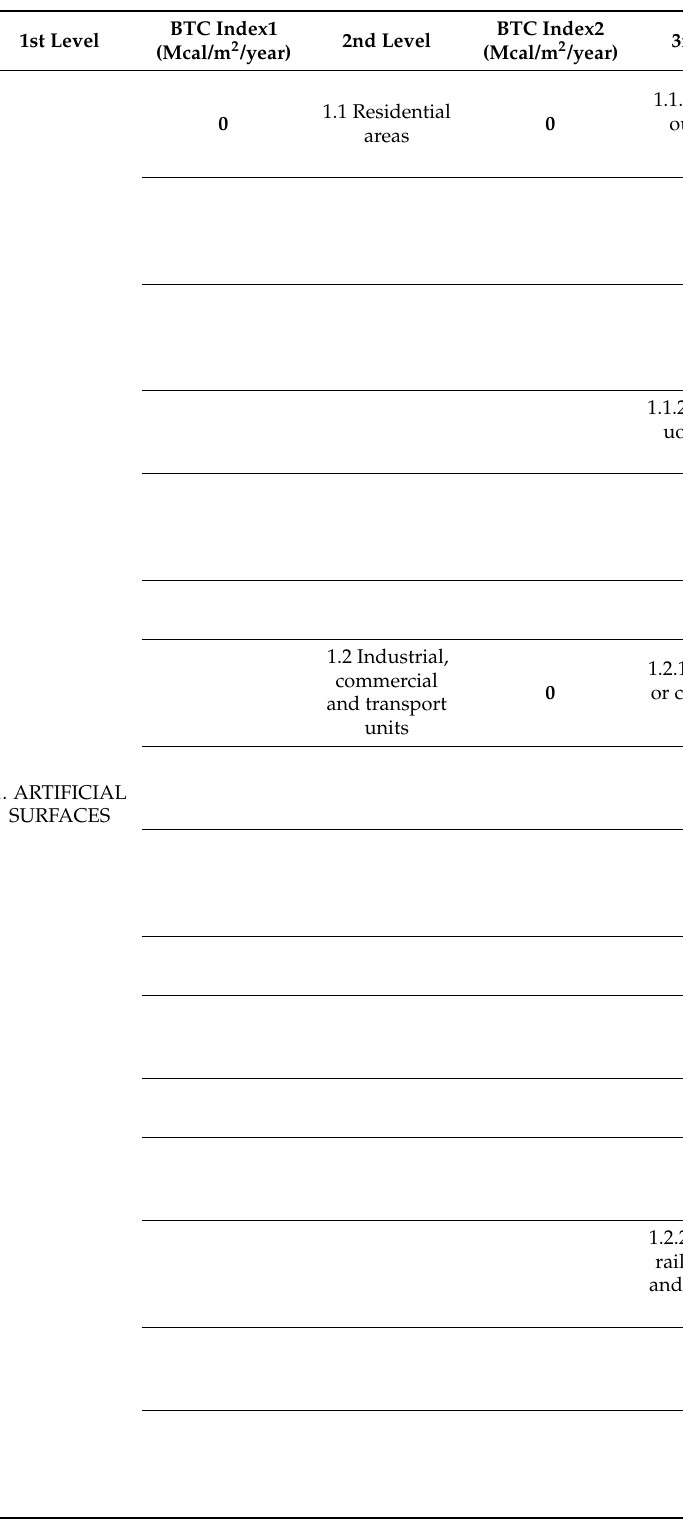
Table A1. Thematic levels of CORINE land cover system and BTC